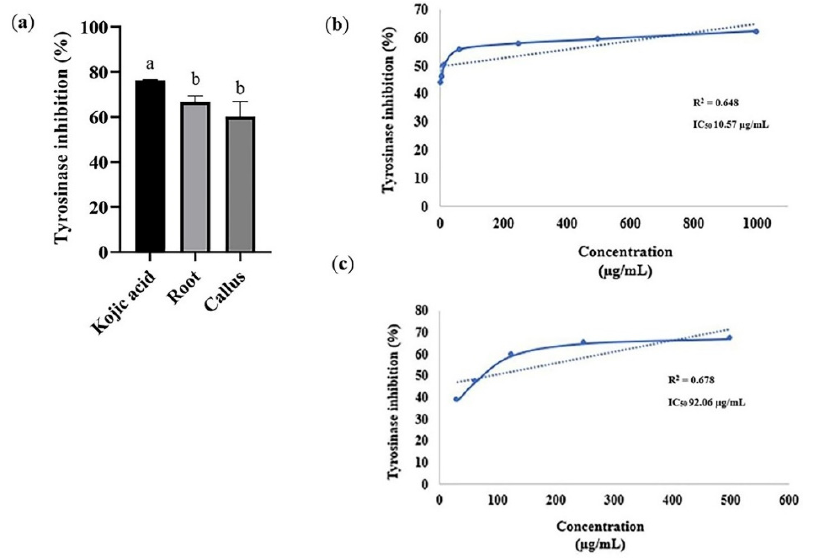
Figure 3. The tyrosinase inhibitory effects of the extracts from root and callus of the mulberry. ( a ) Tyrosinase inhibitory activity of root and callus extracts for the catalysis of L-DOPA. Kojic acid was included as a positive control. Different lowercase letters indicate significant differences between each part analyzed ( p < 0.05). Error bars represent the standard error of the mean of 3 replicates; ( b ) IC 50 curve of mulberry root extract; ( c ) IC 50 curve of callus extract. The values were calculated by nonlinear regression using GraphPad Prism 8.0.1.